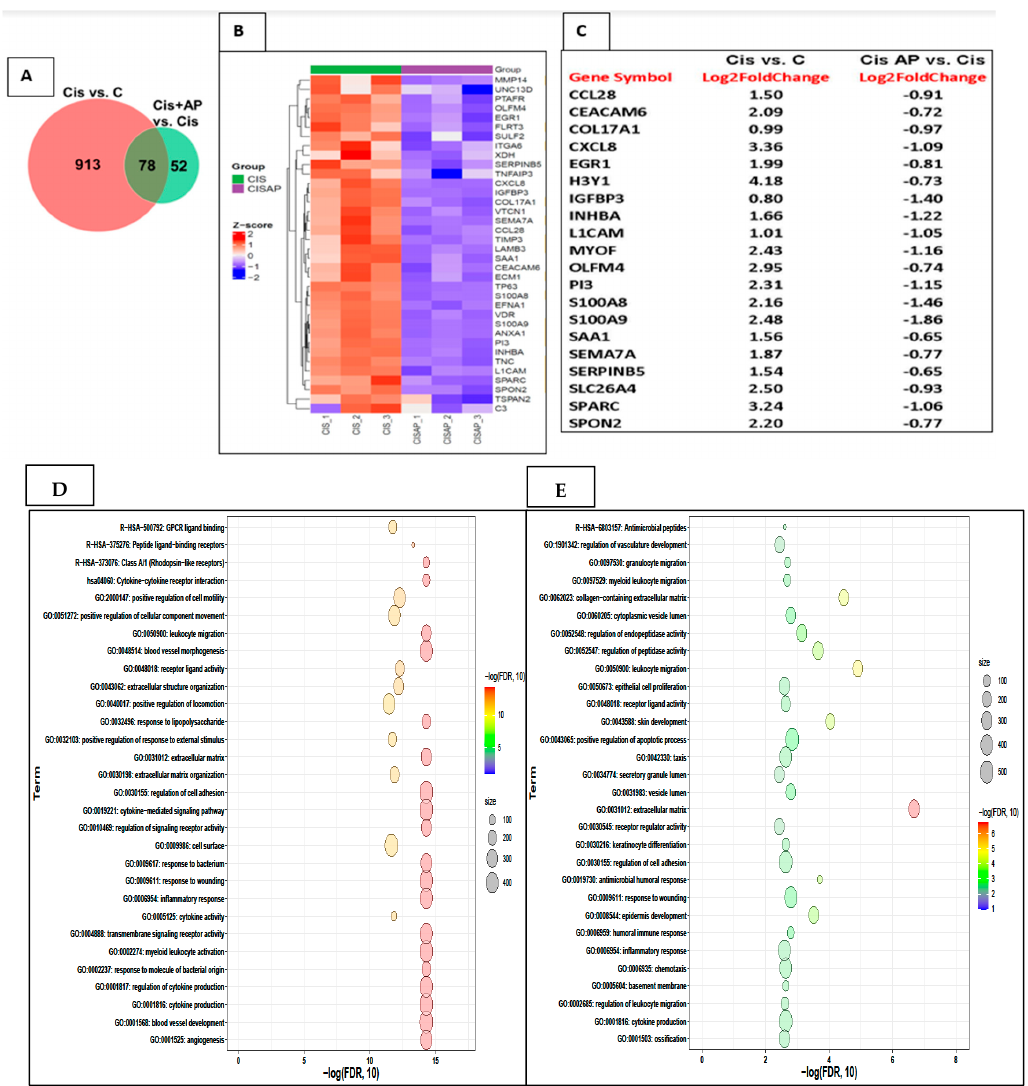
Figure 5. Effects of NK1R antagonism on the transcriptome in Sum 185 TNBC cells. ( A ) Venn diagram showing differentially expressed genes between 2 comparisons CIS vs. C and CIS + AP vs. CIS ( B ) Heat map showing the upregulation (Z-score scaled) of genes linked to pro-inflammatory responses, extracellular matrix (ECM) and cell adhesion in CIS vs. CIS + AP. ( C ) Top 20 differentially expressed genes ( D , E ) Functional enrichment analysis of the upregulated gene sets in CIS and downregulated gene sets in CIS + AP using Gene Ontology (GO) and Kyoto Encyclopedia of Genes and Genomes (KEGG) annotations showing top 30 enriched pathways.